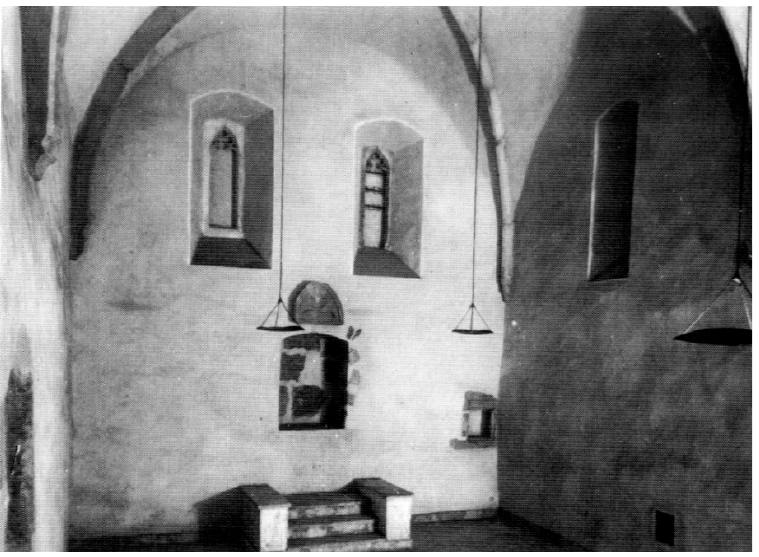
Figure 7. Old Synagogue, Sopron (Creative Commons, Emmanuel Dyan).